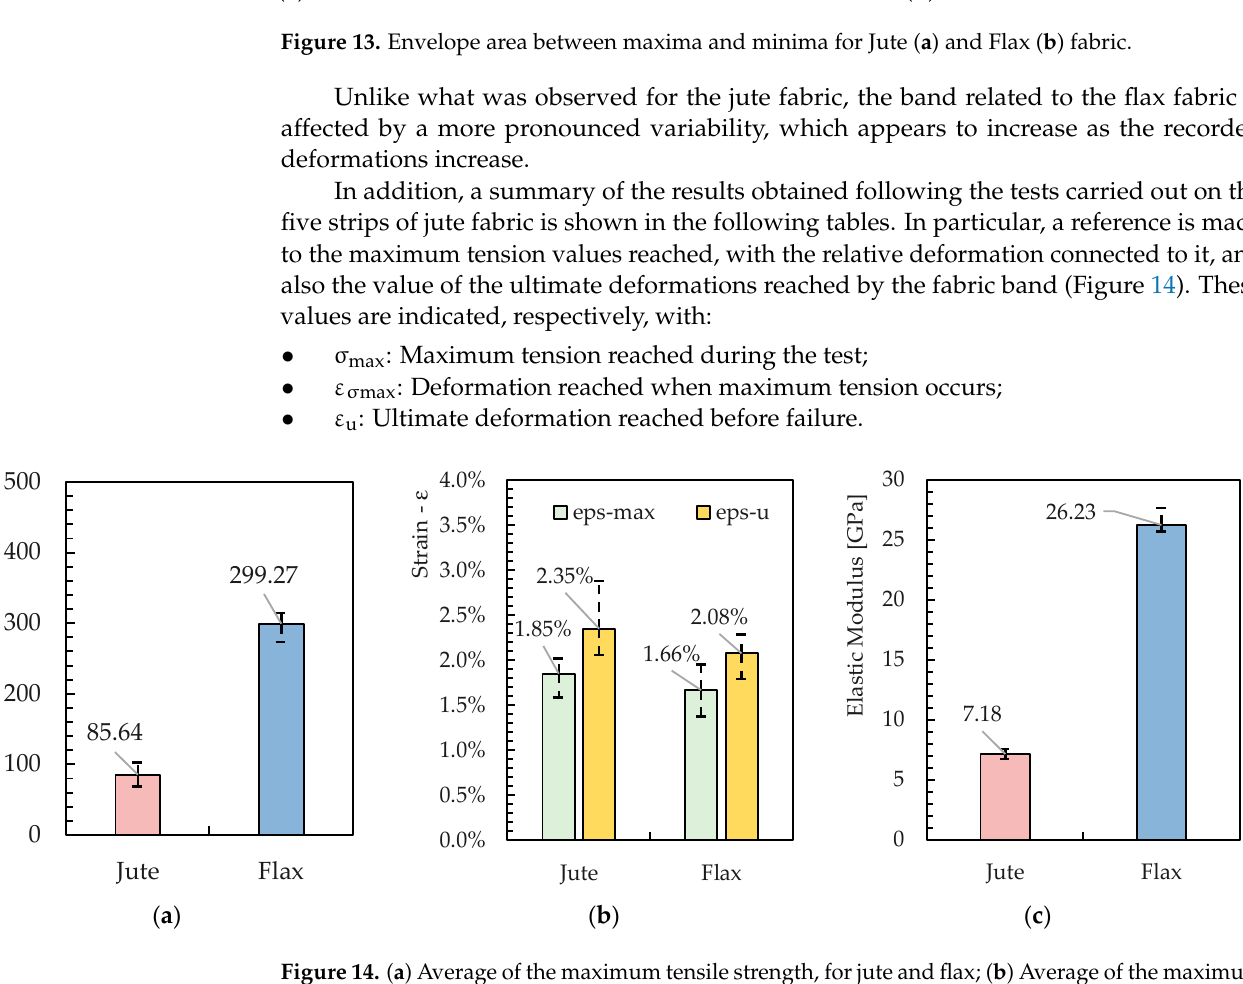
Figure 13. Envelope area between maxima and minima for Jute ( a ) and Flax ( b ) fabric.